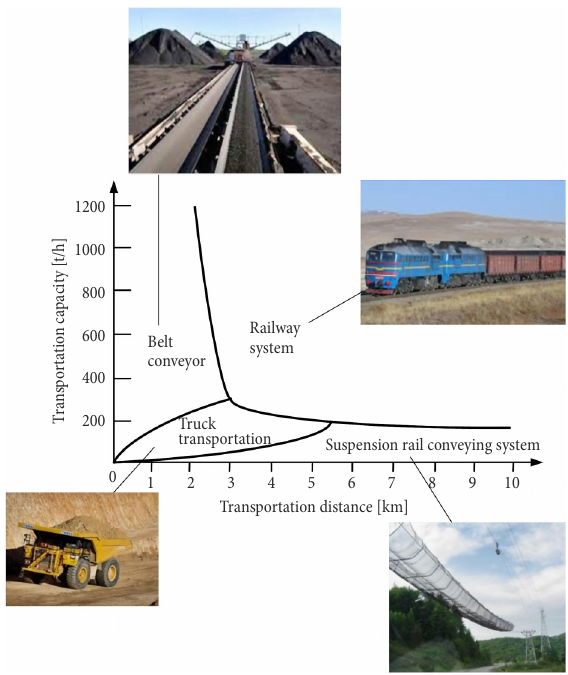
Fig. 1. Preference areas of haulage techniques according to transportation demand and distance (Kose et al.